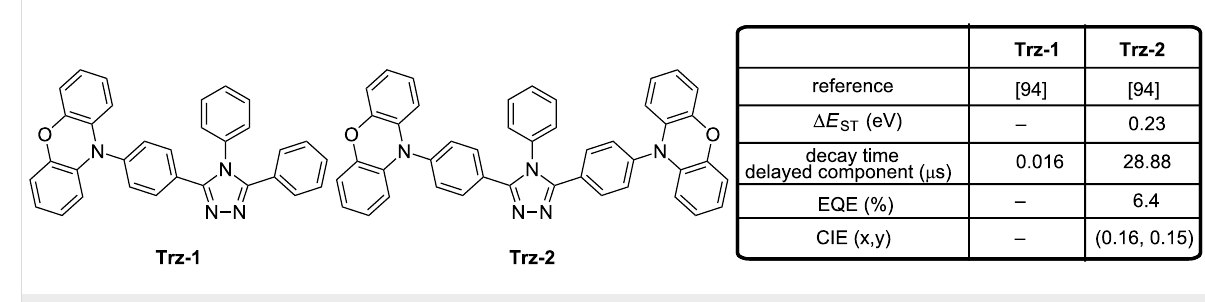
Figure 19: Triazole-based emitters Trz-1 and Trz-2